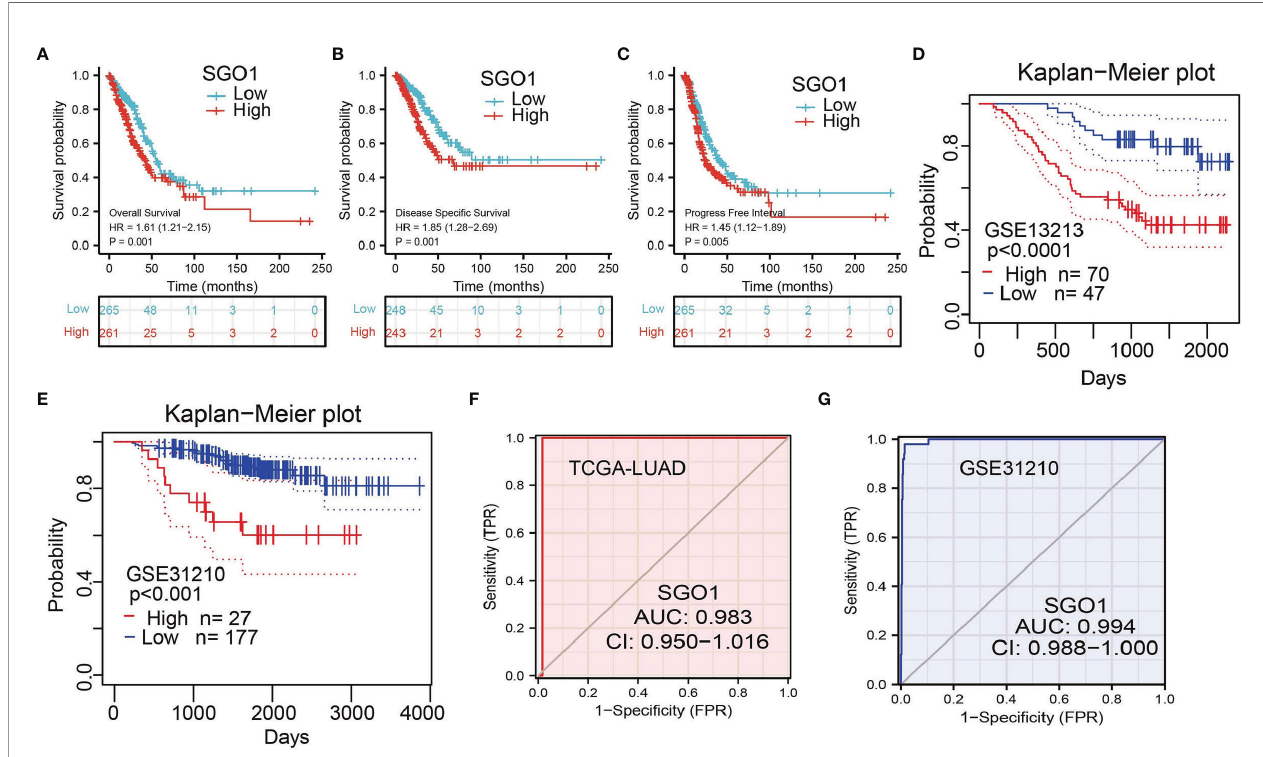
FIGURE 4 | ROC and Kaplan – Meier curves of SGO1. (A – C) Kaplan – Meier survival curves showed that lung adenocarcinoma patients with high SGO1 expression exhibited poor overall survival, disease-speci fi c survival, and progression-free survival of SGO1 in LUAD determine by TCGA-LUAD dataset. (D – E) Validation of the prognosis of SGO1 in LUAD using the GEO dataset. (F,G) ROC curves were used to determine the diagnostic value of SGO1 in lung